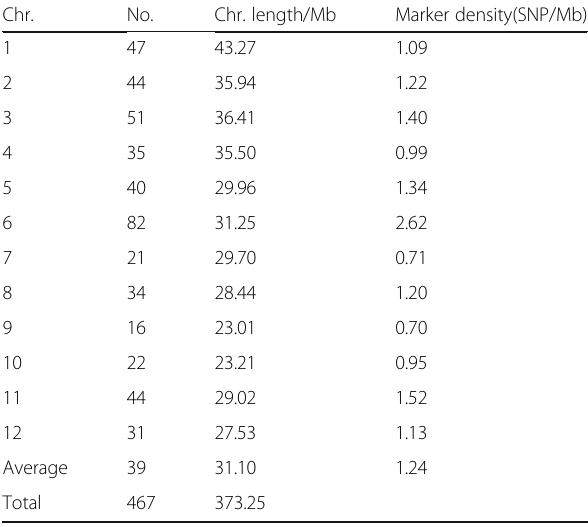
Table 2 Distribution of valid KASP markers within each chromosome